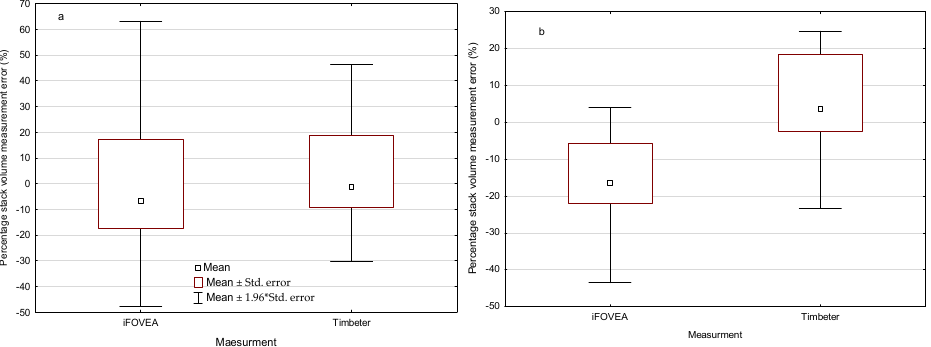
Figure 6. Statistical characteristics of single stack volume measurement errors by measurement method: ( a ) broadleaf wood; ( b ) coniferous wood. method: ( a ) broadleaf wood; ( b ) coniferous wood.